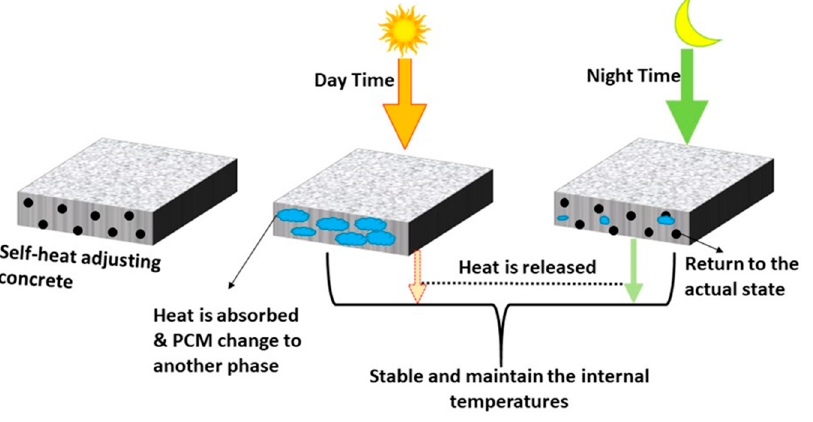
Figure 15. Schematic diagram of the mechanism of self-temperature adjusting concrete